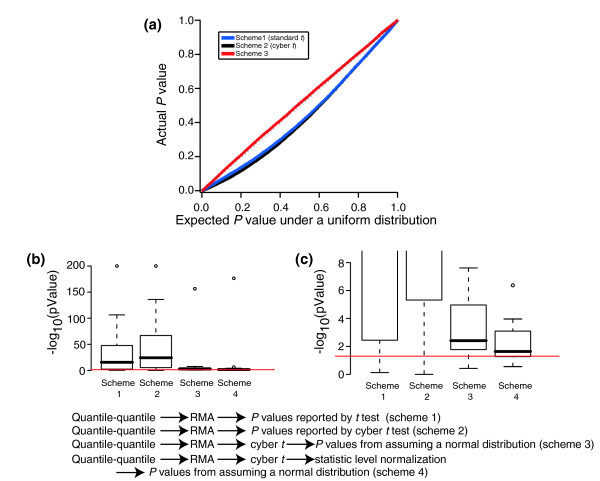
Actual versus expected P values under uniform distribution for null genes of Latin Square 2× comparisons. (a) Actual versus expected P values for the comparison of experiment 10 versus 11. Black dashes indicate the y = x diagonal. (b) Box plots showing the results of the Kolmogorov-Smirnov test for each of the 14 Latin Square 2× comparisons under the null hypothesis that the observed distribution of P values was the same as a uniform distribution of P values. The red line is the P = 0.05 level. (c) Same data as in panel b but with a magnified y-axis.